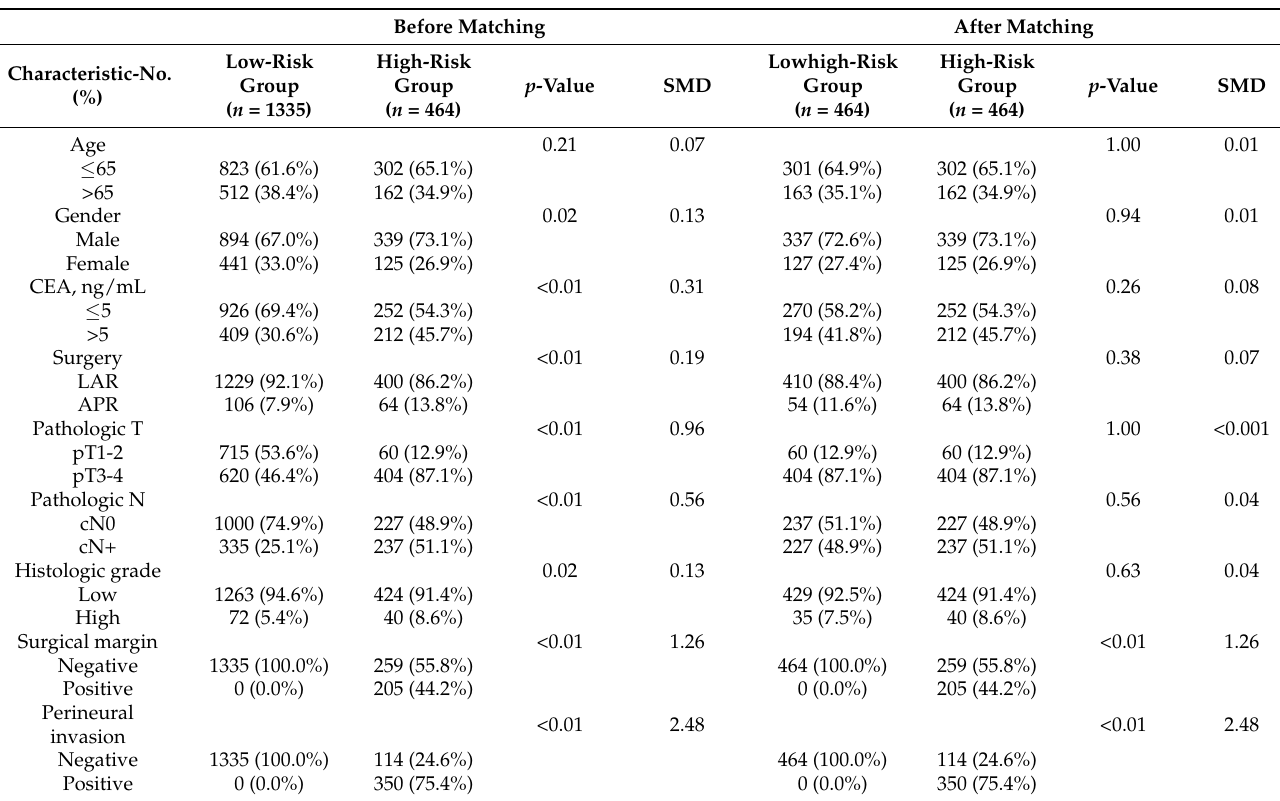
Table 1. Patient and tumor characteristics before and after